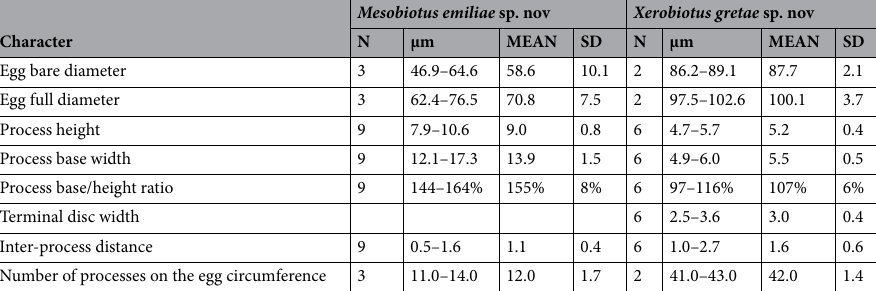
Table 2. Summary of the morphometric data of the eggs of two of the species new to science. Within the table the measures of the selected structures (characters; range in µm), the number of measurements for each character, and the mean and the standard deviation calculated for each character